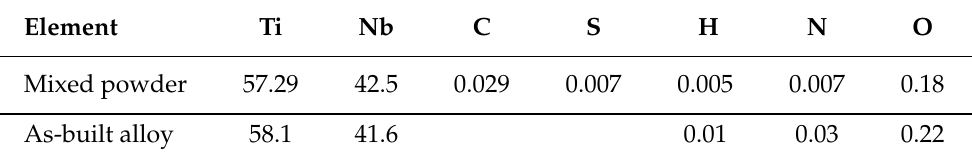
Table 1. Chemical compositions (in wt %) of the powders and the as-build alloy.